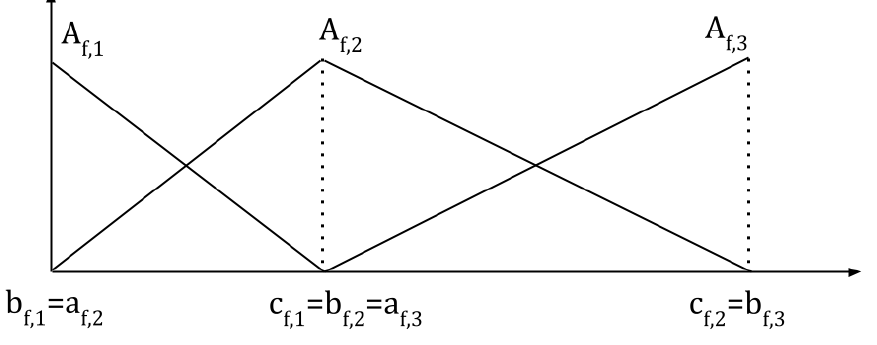
Figure 2. An example of a strong fuzzy